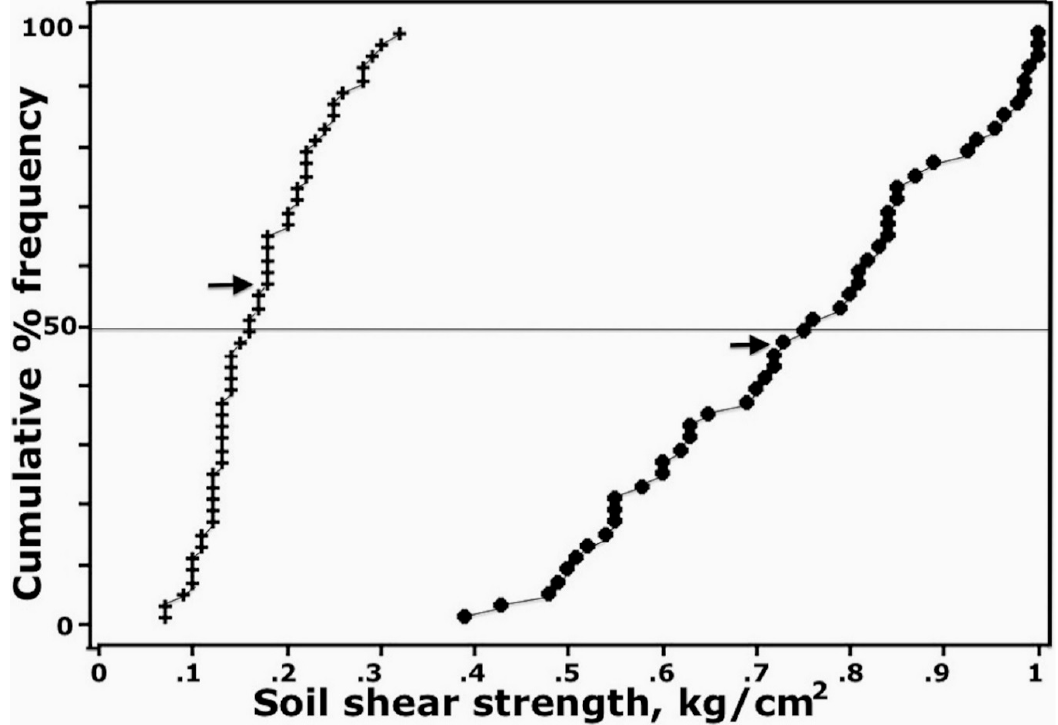
Figure 6. Cumulative-frequency distributions for surficial Torvane soil shear strength (kg/cm 2 ), on 50 pairs of samples. Key . Dark arrows indicate mean values. Line of dark dots on the right indicates measurements under LIs, below k ū paoa canopy; median: 0.750 kg/cm 2 , mean: 0.747 kg/cm 2 . Line of crossmarks on the left show readings on paired bare soils; median: 0.160 kg/cm 2 , mean: 0.172 kg/cm 2 .